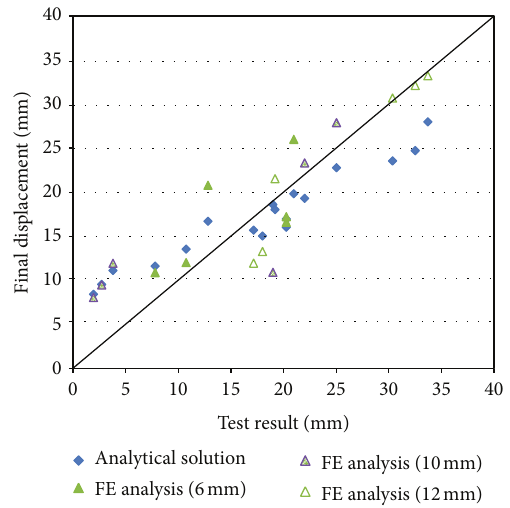
Figure 8: A comparison of the analytical solution, the numerical solution, and the test results.